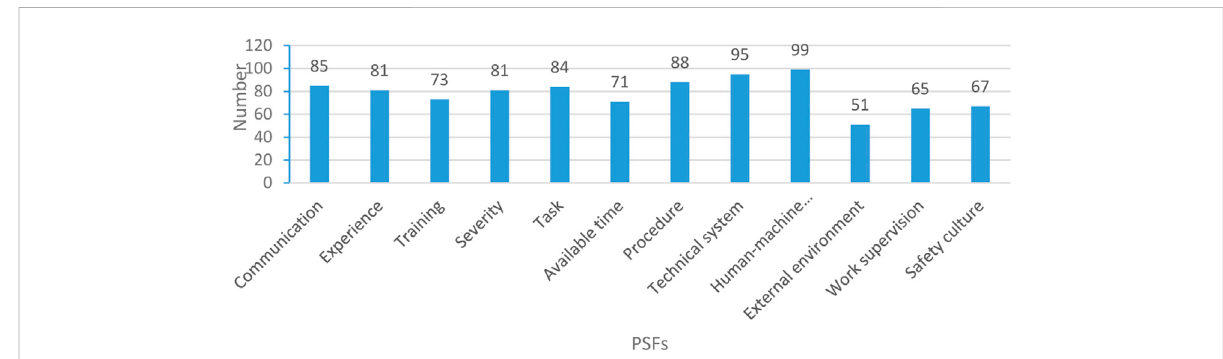
FIGURE 4 Major PSFs statistics.